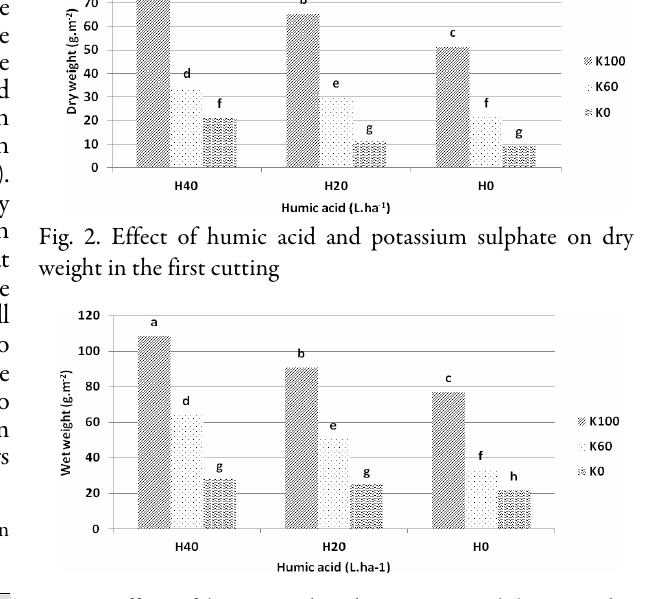
Fig. 3. Effect of humic acid and potassium sulphate on dry weight in the second cutting